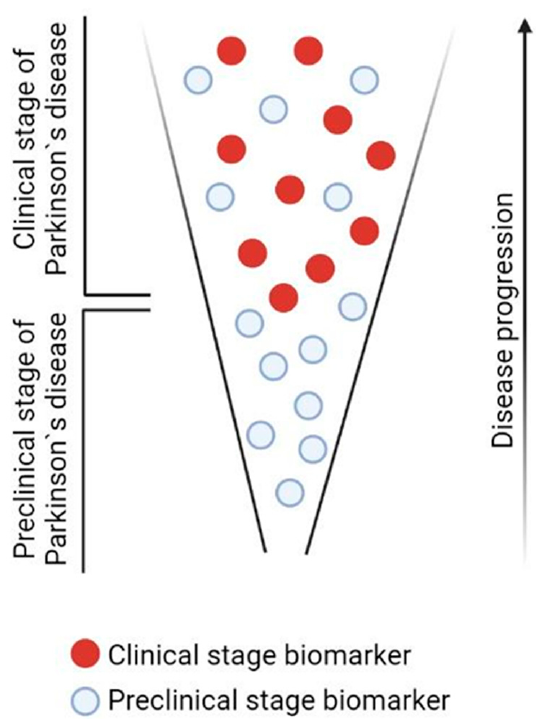
Figure 12. Schematic representation of the emergence of new biomarkers in the blood as Parkinson’s disease progresses.